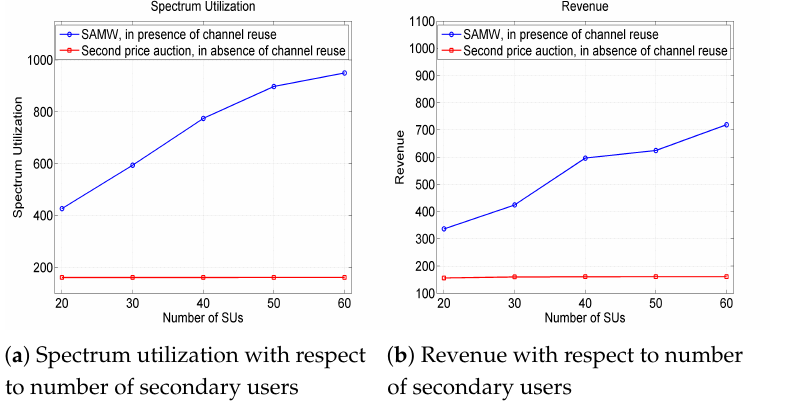
Figure 10. Spectrum utilization and revenue for SAMW and second-price auction with respect to number of secondary users.